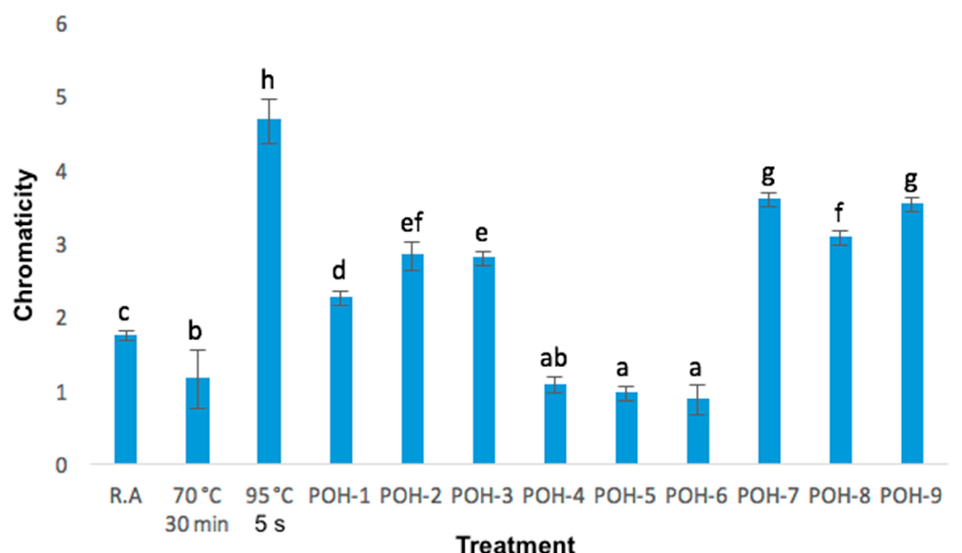
Figure 5. Changes in the hue in raw aguamiel and after pasteurization and ohmic heating treatments ; data is mean (±standard deviation) of three replicates. a, b, c, d, e, f, g letters indicate significant differences ( p < 0.05).